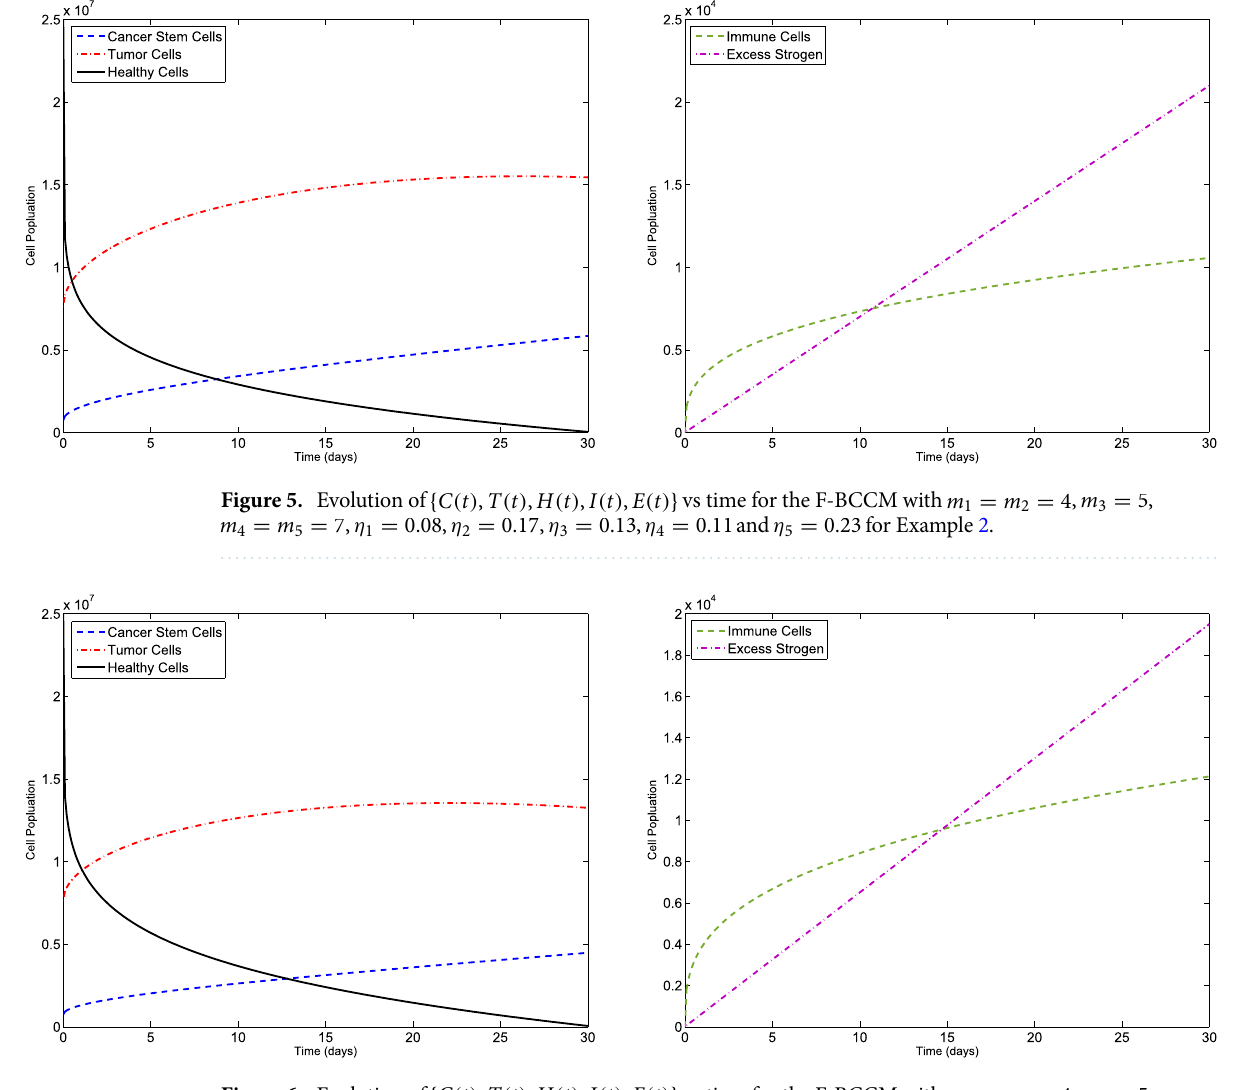
Figure 6. Evolution of { C ( t ) , T ( t ) , H ( t ) , I ( t ) , E ( t ) } vs time for the F-BCCM with m 1 = m 2 = 4 , m 3 = 5 ,